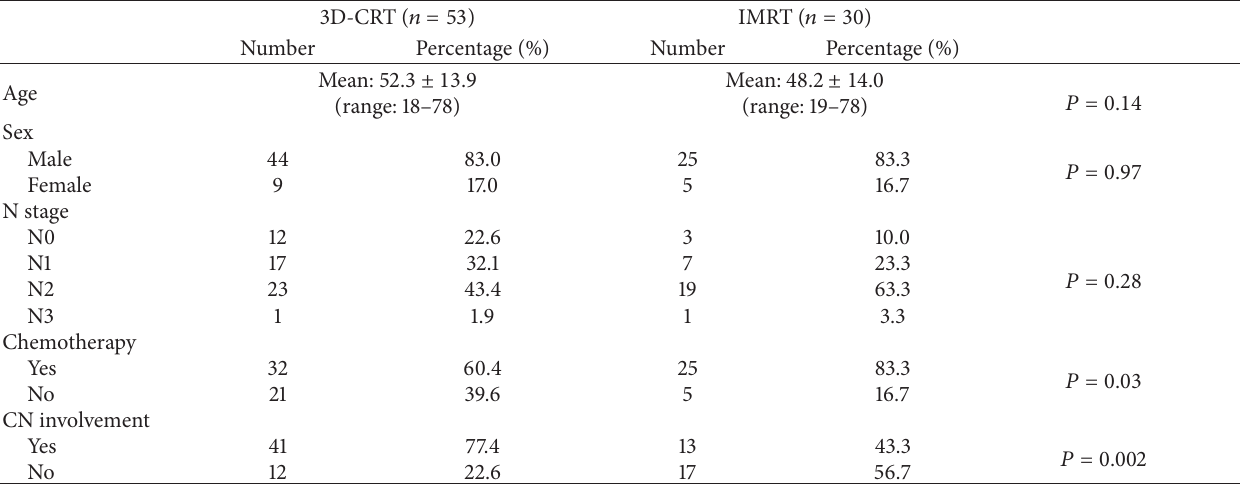
Table 1: Patients characteristics in different radiotherapy techniques ( 𝑛 = 83